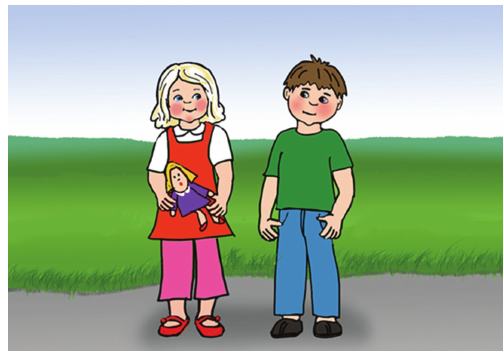
Figure 1: Max and Sara, the children in the intervention. Illustra- tions by Gunilla W¨arnstr¨om.